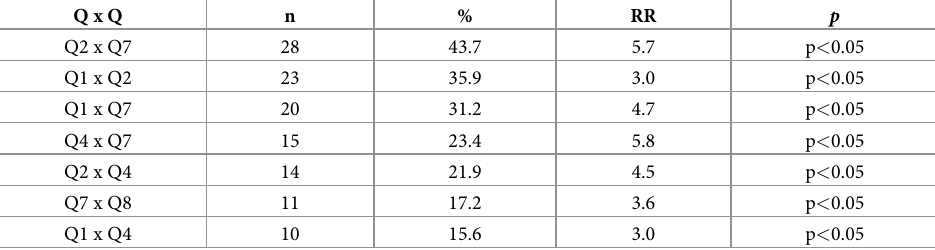
Table 2. Distribution of crossing frequencies between the five most marked questions of LSQ and respective risk relatives. Q x Q n %